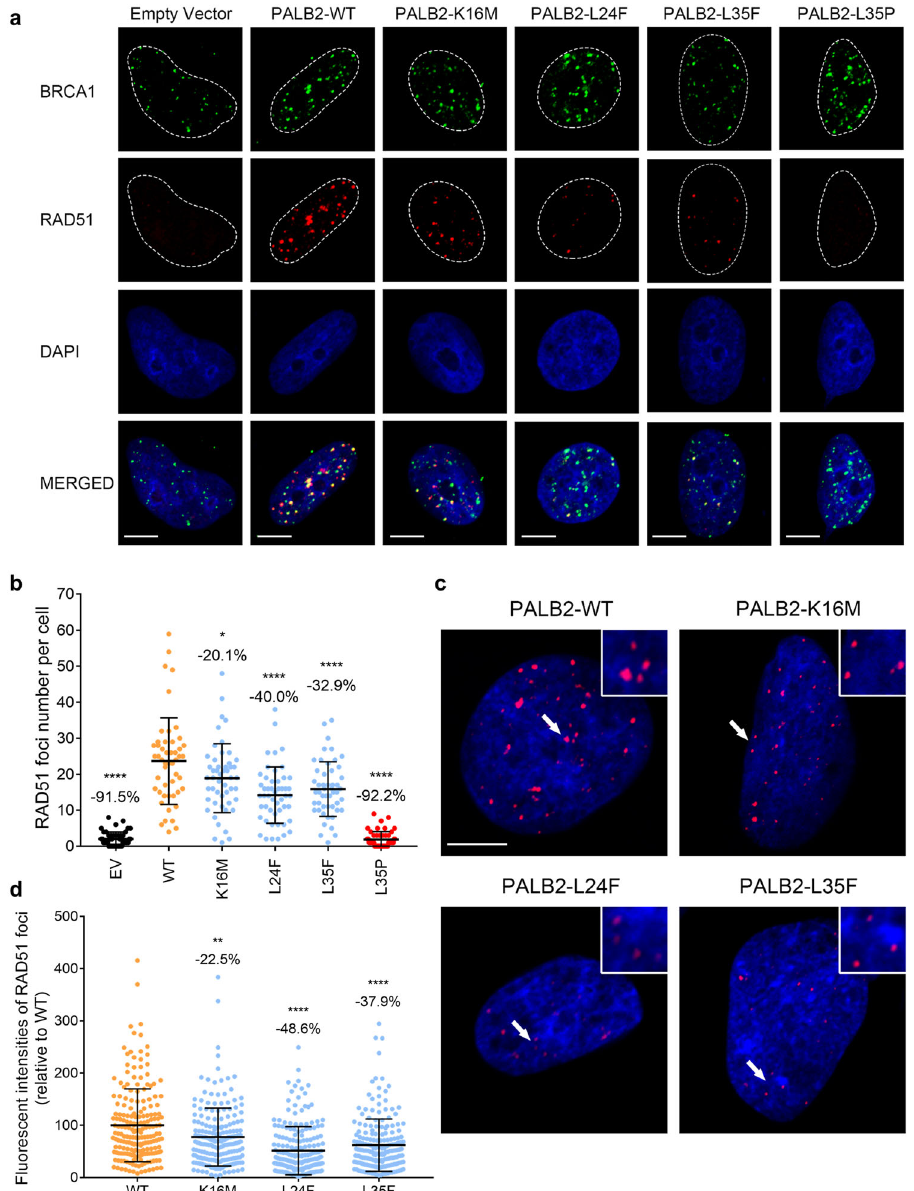
Fig. 4 Effects of PALB2 VUSs on RAD51 foci formation. a The PALB2 VUSs reduced RAD51 foci formation in response to DNA damage. Representative images of RAD51 foci formation in EUFA1341 cell lines stably expressing PALB2 constructs (or an empty vector, EV). BRCA1 was co-stained to determine sites of DNA damage and co-localization with RAD51. Cells were fi xed 6 h after 10 Gy of IR and analyzed by immuno fl uorescence. Scale bar, 5 μ m. b Quanti fi cation of RAD51 foci in BRCA1 foci-positive cells expressing the indicated PALB2 variant. Results represent the mean values ( ± SD) of three independent experiments ( n = 50 cells per condition). Statistical signi fi cance was analyzed by one-way ANOVA and Dunnett ’ s multiple comparisons test. * P < 0.05; **** P < 0.0001. c The PALB2 VUSs diminished the RAD51 foci intensity in response to DNA damage. Representative immuno fl uorescence images of RAD51 foci intensity in BRCA1 foci-positive EUFA1341 cells expressing the indicated PALB2 variants. Scale bar, 5 μ m. d Quanti fi cation of fl uorescent intensities of RAD51 foci in BRCA1 foci-positive cells expressing the indicated PALB2 variants. Results represent the mean values ( ± SD) of 200 RAD51 foci (relative to the WT mean). Statistical signi fi cance was analyzed by Kruskal-Wallis test and Dunn ’ s multiple comparisons test. ** P < 0.01; **** P <